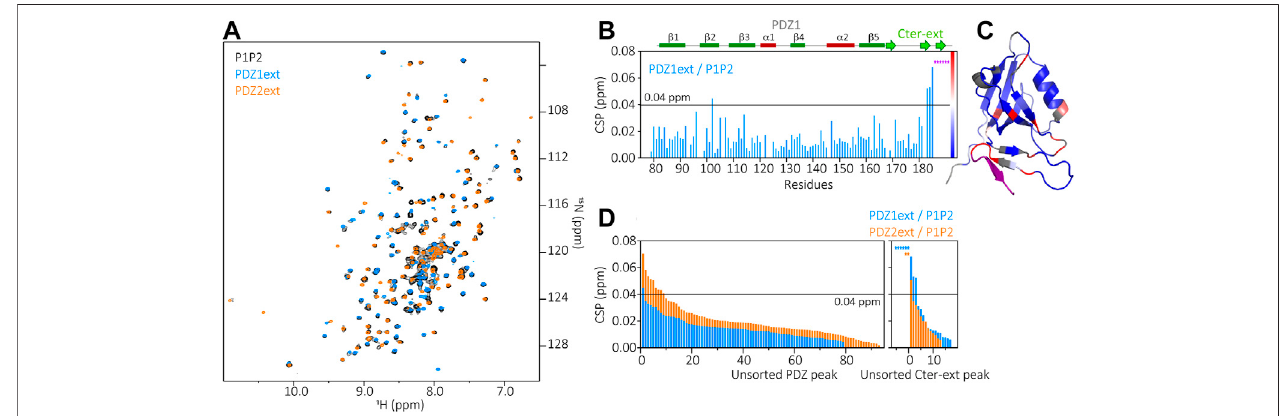
FIGURE 4 | (A) Superimposition of P1P2 (black), PDZ1ext (blue) and PDZ2ext (orange) 1 H- 15 N HSQC spectra. (B) Chemical Shift Perturbations (CSP) measured for each residue of PDZ1ext when comparing PDZ1ext to P1P2. Purple stars correspond to residues of the extension which can not be assigned in P1P2 due to large CSP or missing peaks, indicating large changes of environment. Secondary structures are represented above the barplot. (C) Mapping of the PDZ1ext/P1P2 CSPs on PDZ1ext AlphaFold model with the color coding indicated in (B) . (D) Unsorted CSPs measured for each residue when comparing PDZ1ext to P1P2 (blue) and PDZ2ext to P1P2 (orange). Colored stars correspond to residues which can not be assigned in P1P2 due to large CSP or missing peaks, indicating large changes of environment.